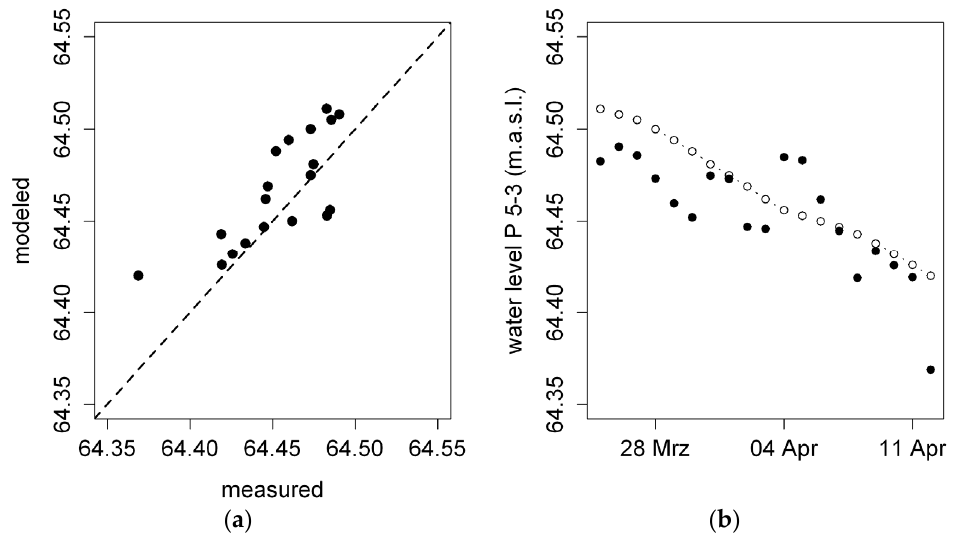
Figure 5. ( a ) scatterplot and ( b ) comparison of modeled water levels (hollow dots) and measured water levels (filled dots) at P5-2 during the validation period (24 March–2 April 2011). The 1:1 ratio is given by the dashed line.